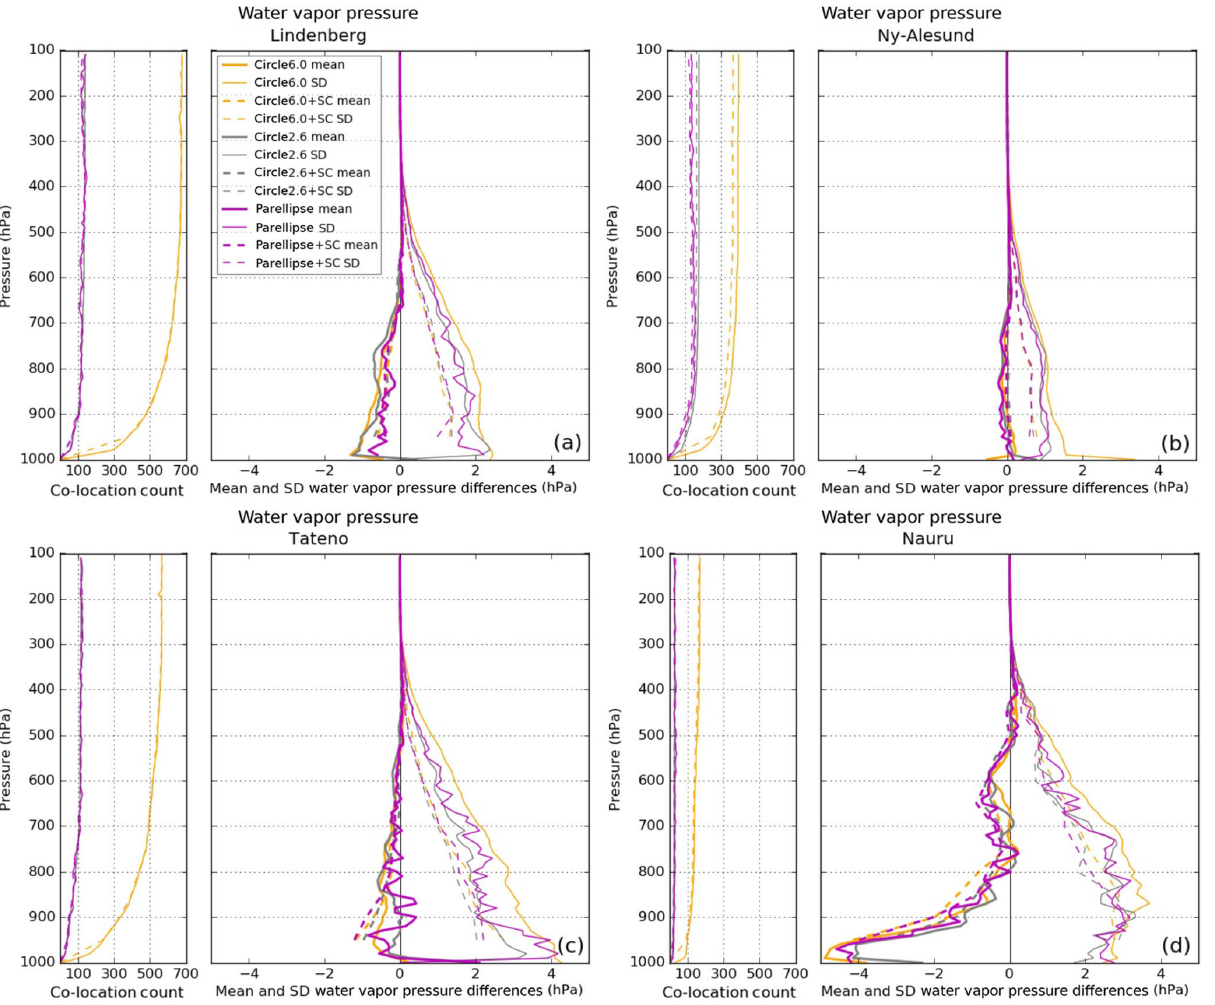
Figure A3. Same as Fig. A1 for water vapor